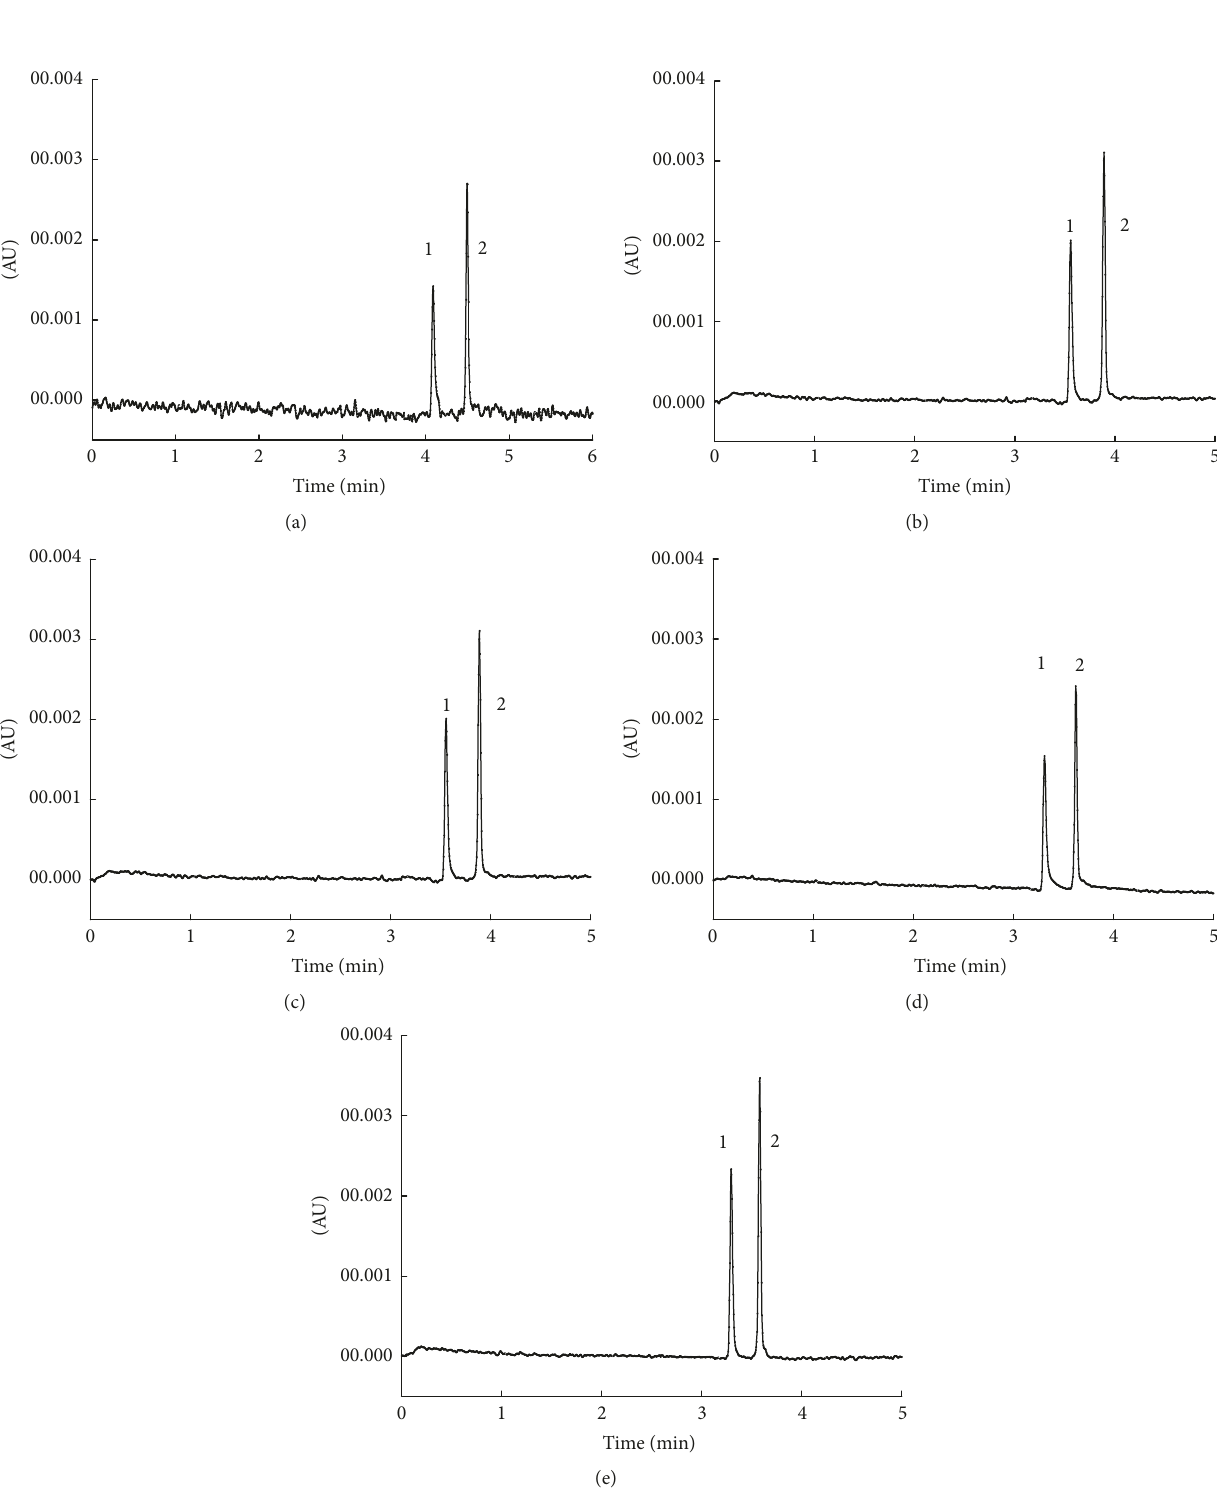
Figure 5: Effect of different temperature on the separation. Chromatogram identification: (a) 20 ∘ C; (b) 22 ∘ C; (c) 25 ∘ C; (d) 27 ∘ C; (e) 30 ∘ C. Separation conditions and peak identification were as in Figure